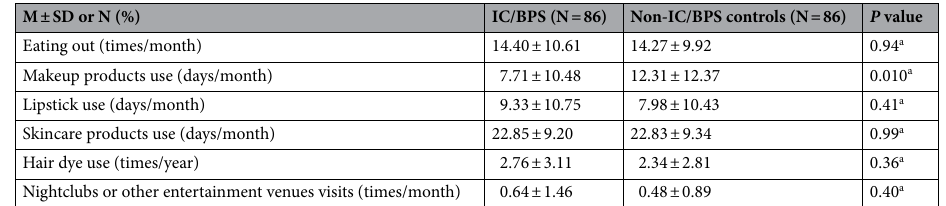
Table 5. Comparison of frequency of using makeup products and social activities. M mean, N number, SD standard deviation. a t